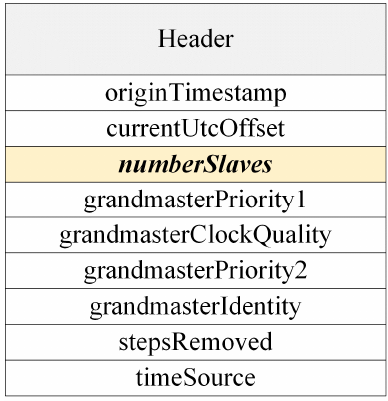
Figure 5. The structure of the revised Announce message used in the BSHSM algorithm.